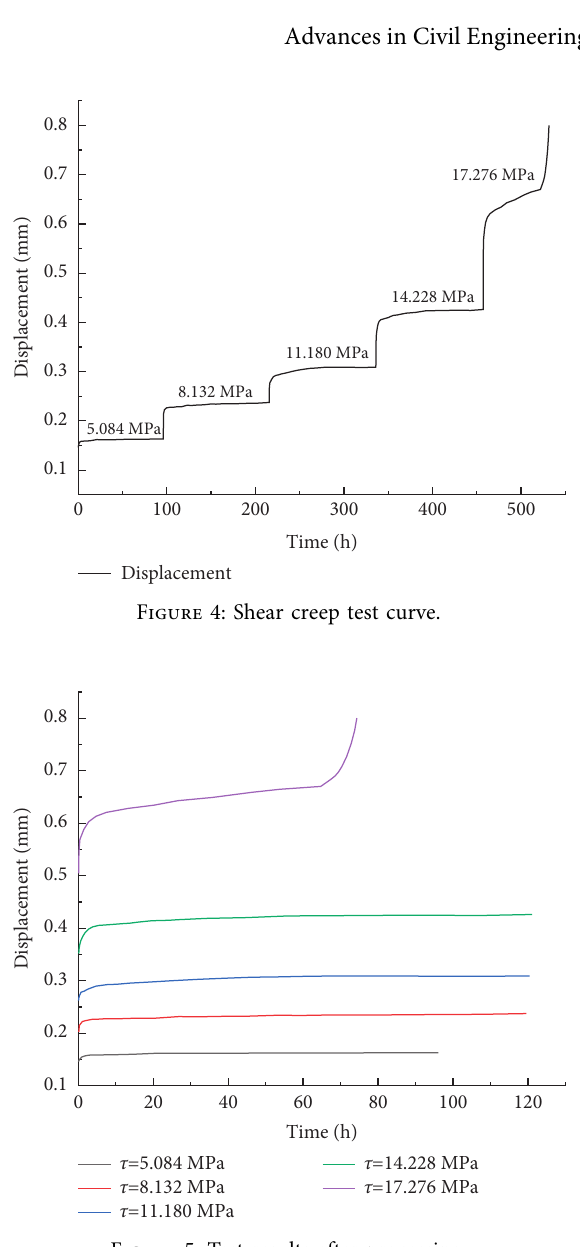
Figure 5: Test results after